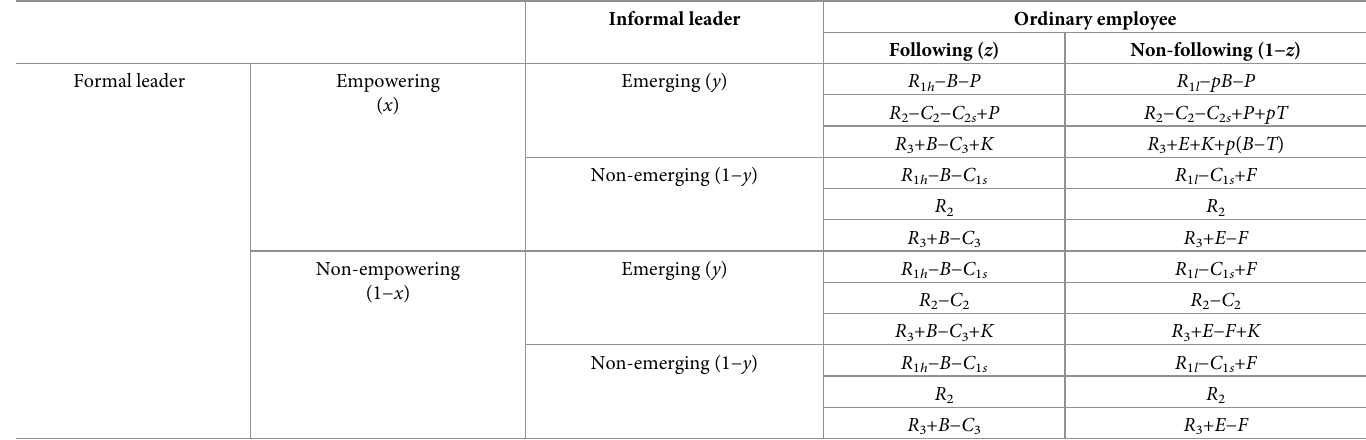
Table 3. Benefit matrix of tripartite evolutionary